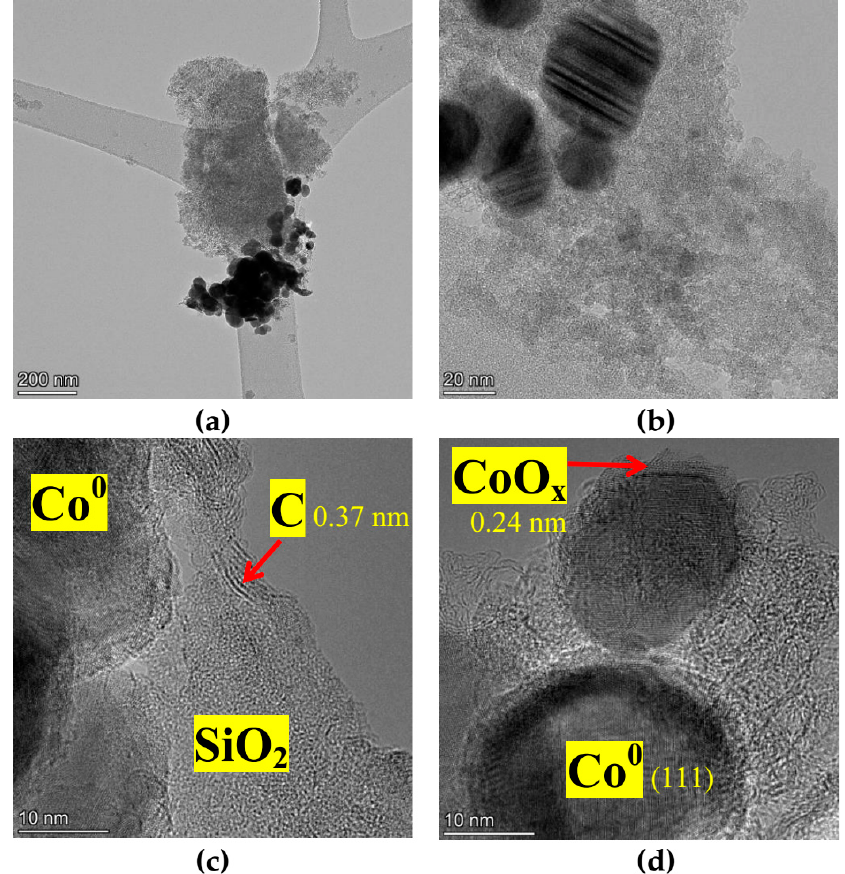
Figure 2. Low ( a ) and higher ( b – d ) magnification TEM images of as-synthesized Co-N-C/SiO 2 catalyst, confirming the presence of metallic cobalt particles of different sizes, ( d ) CoO x on their surface (interlayer spacing of 0.24 nm) and ( c ) fragments of graphitic carbon (interlayer spacing of 0.37 nm).